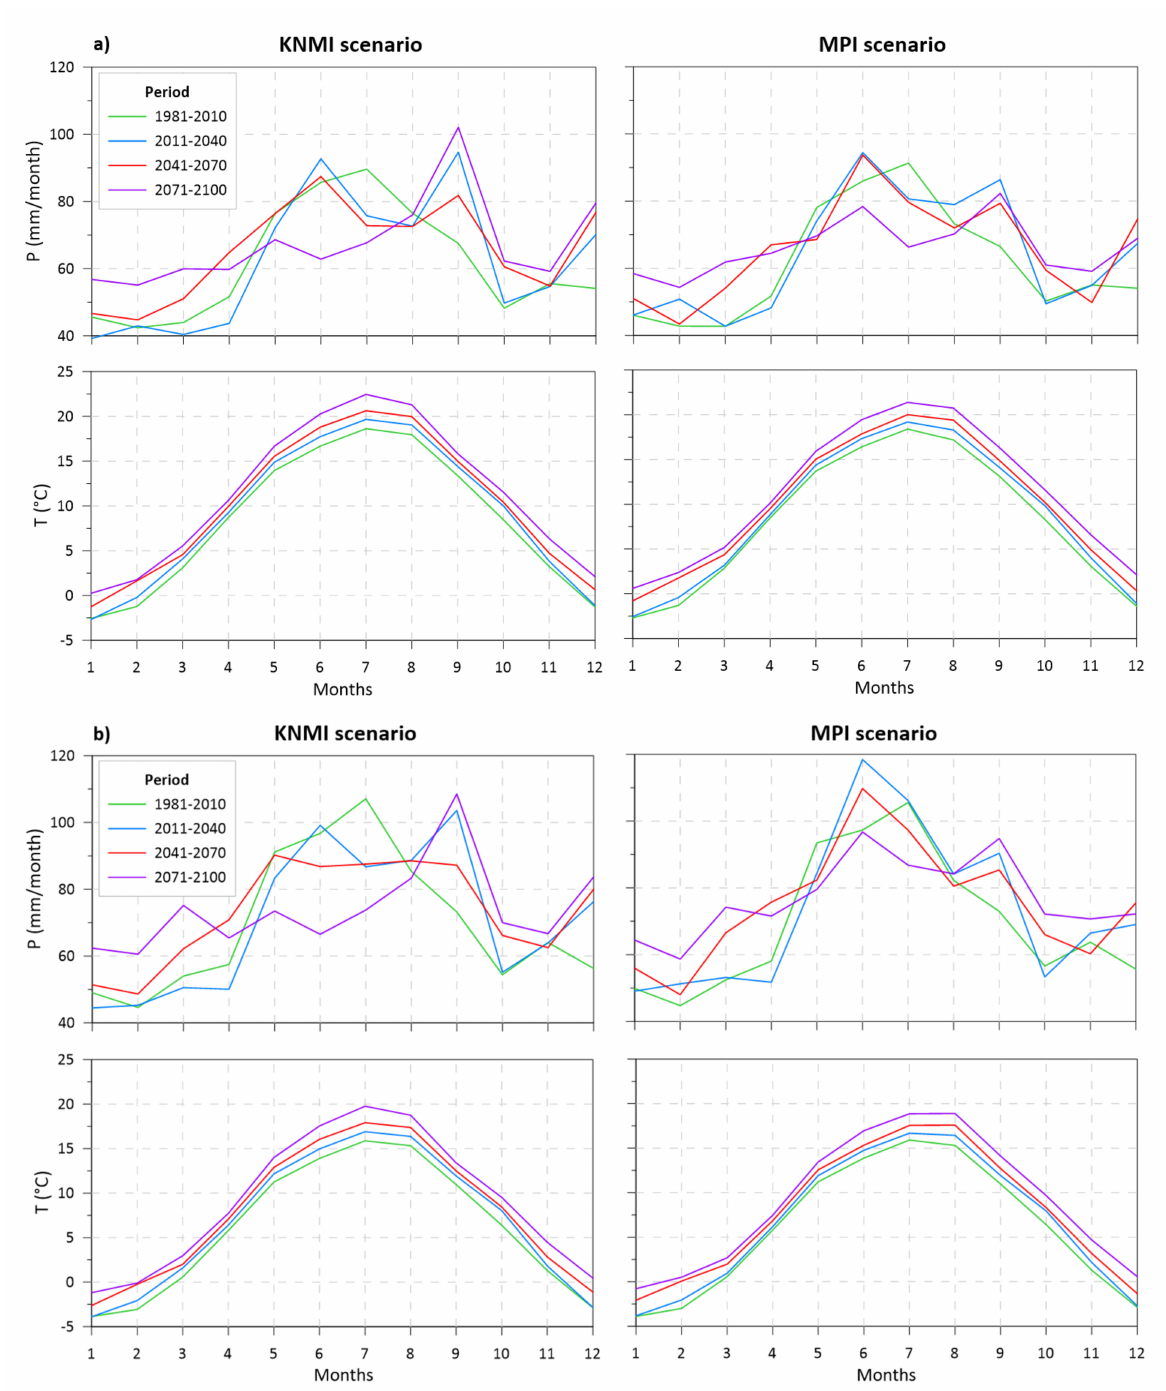
Figure 3. Seasonal variability of the long-term mean monthly air temperature and precipitation totals for the KNMI and MPI climate scenarios: ( a ) for the river basins with a mean elevation < 435 m a.s.l.; ( b ) for the river basins with a mean elevation > 435 m a.s.l. The lines show the basin